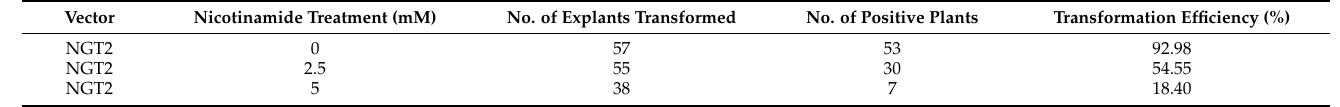
Figure 4. Callus growths and shoot regeneration status on the selection culture medium containing different concentrations of nicotinamide during wheat genetic transformation. ( a ) Callus growth status on WLS-P5 medium. ( b ) Shoot regeneration status on LSF-P5 medium. Table 5. Effects of nicotinamide on the efficiency of Agrobacterium -mediated genetic transformation of wheat.